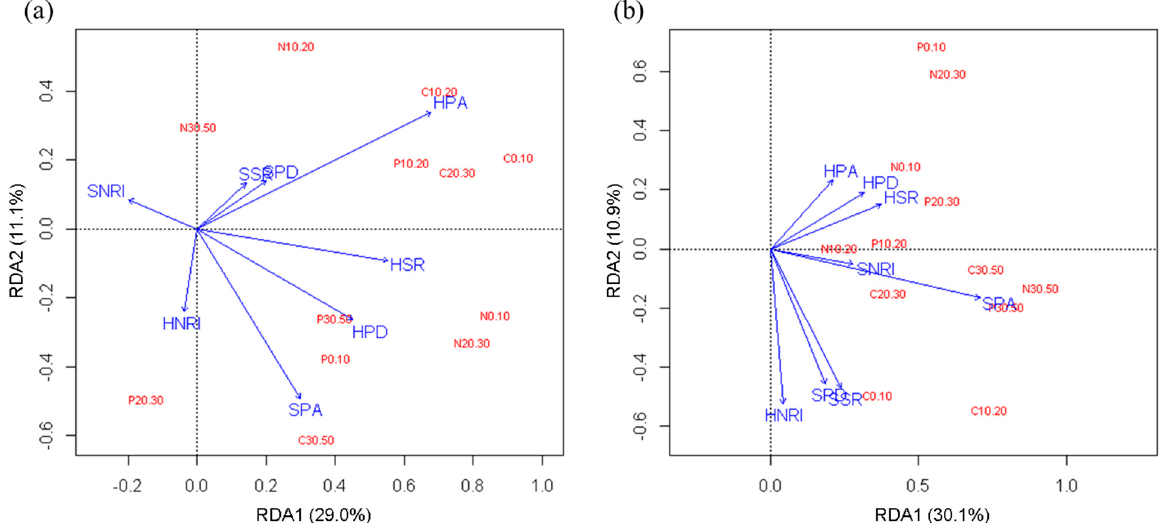
Figure 4. RDA ordination diagram for soil nutrients and vegetation factors in the R. pseudoacacia forest ( a ) and P. tabuliformis forest ( b ). SSR, shrub species richness; SPA, shrub plant abundance; SPD, shrub phylogenetic diversity; SNRI, shrub NRI; HSR, herb species richness; HPA, herb abundance; HPD, herb phylogenetic diversity; HNRI, herb NRI. C0.10 to C30.50 represent the SOC of each soil layer; N0.10 to N30.50 represent the TN of each soil layer; and P0.10 to P30.50 represent the TP of each soil layer.